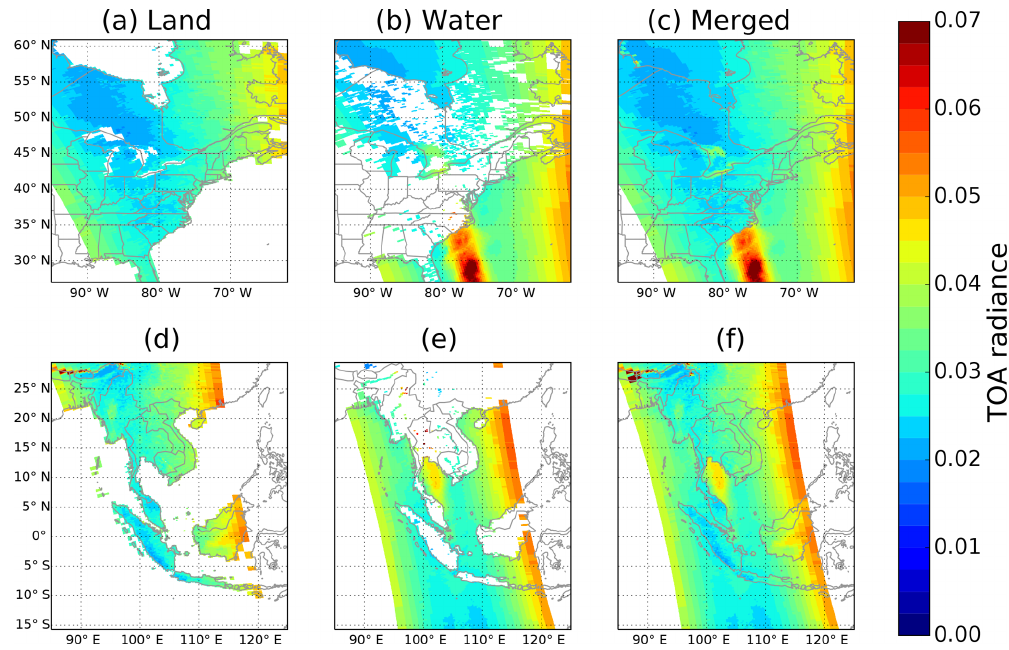
Figure 3. Pixel-based simulated TOA radiance over land (a, d) when the pixel land fraction is larger than 5%, water (b, e) when the pixel water fraction is larger than 5%, and the merged scene using Eq. (3) (c, f) . Panels (a) to (c) : North America; panels (d) to (f) : SE Asia.